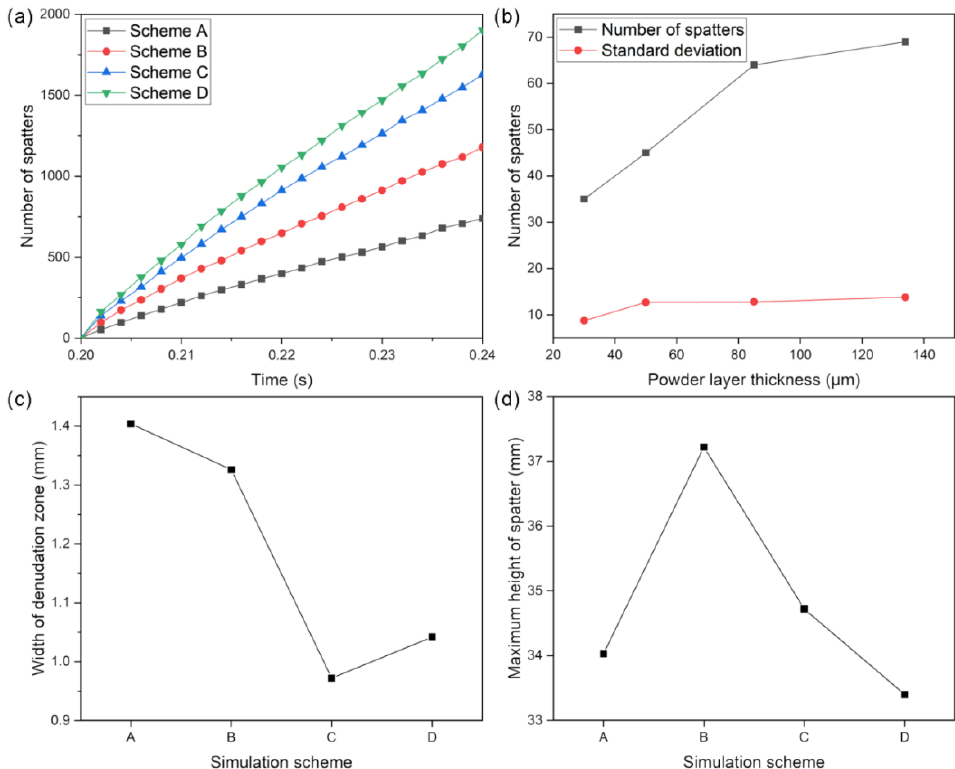
Figure 8. Side view of particle distribution at t = 0.22 s for different simulation schemes (the particles are enlarged 10 times to visualize the particle positions; particle colors represent particle speeds).